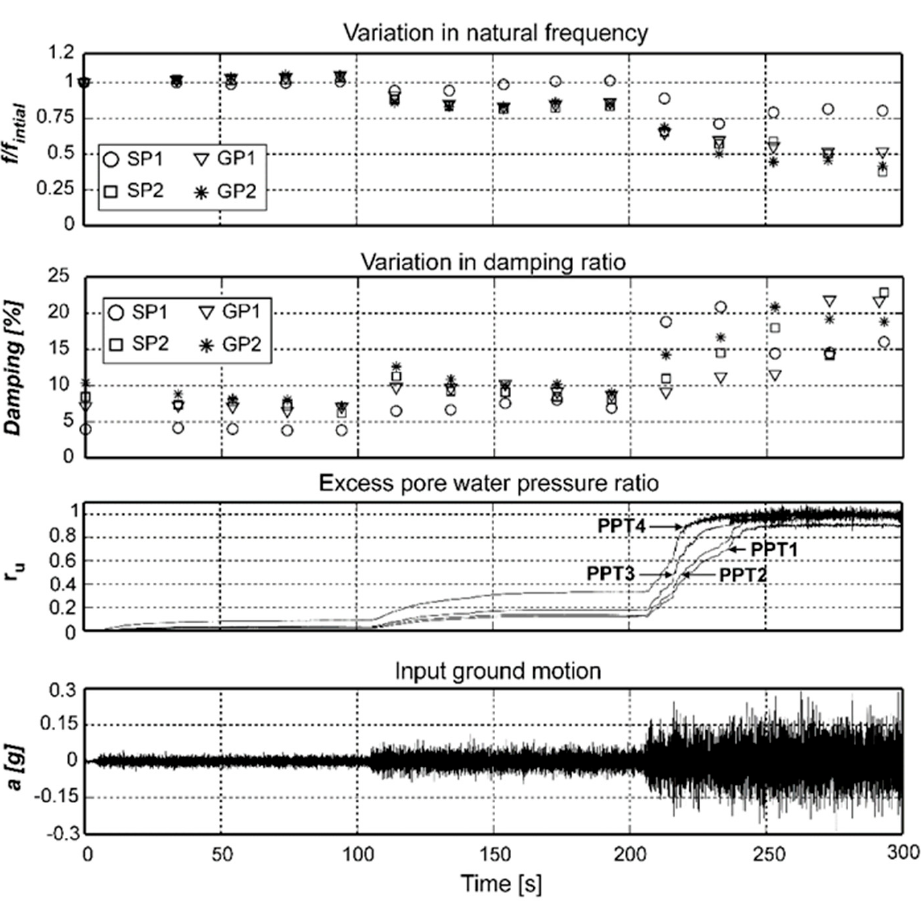
Figure 31. Shaking table tests on small-scale models of monopile- and pile-supported structures for the jacket: ( a ) geotechnical model container and shaking table; ( b ) model tests representing monopile-supported structures (SP1 and SP2) and 2 × 2 pile-supported jacket.